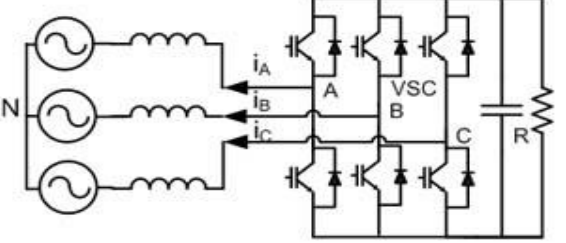
Figure 1. Schematic diagram of a voltage source converter (VSC) .